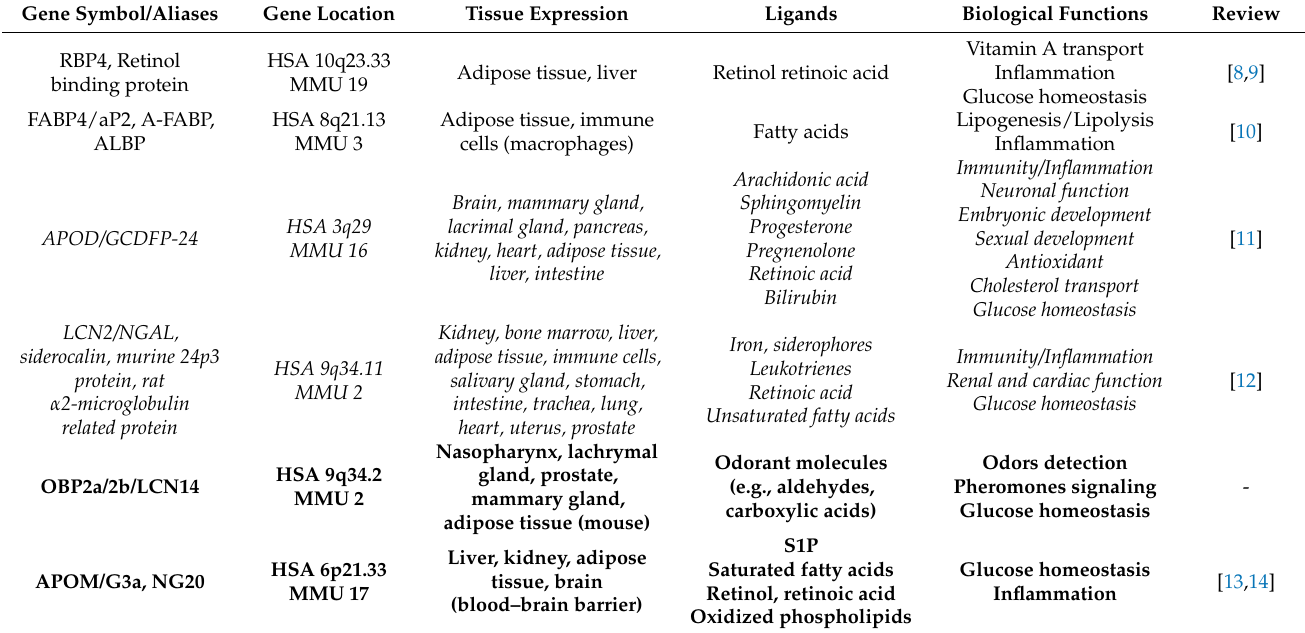
Table 1. Adipose-derived lipid-binding proteins